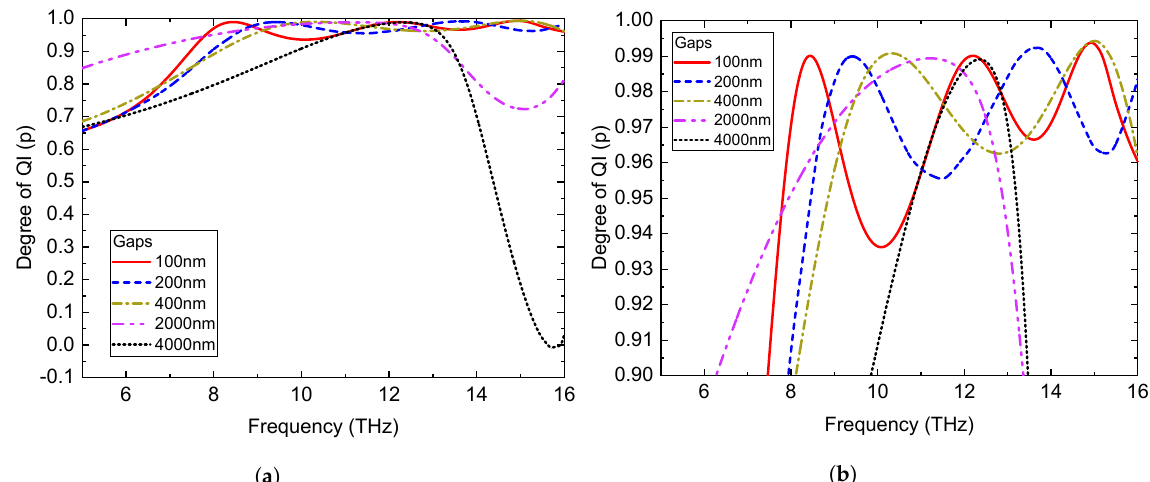
Figure 5. ( a ) The degree of QI ( p ) in a dimer of Bi 2 Se 3 microspheres with 2 µ m radius, as a function of frequency for different gaps. In order to study in more detail the behavior of these curves for high values of p , in figure ( b ) we have zoomed the upper part of figure ( a ) with the values of p lying in the range [ 0.9,1.0 ]